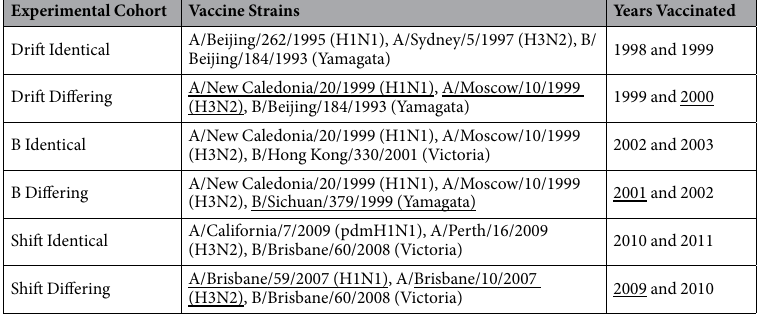
Table 1. Experimental Cohorts, Virus Vaccine Strains and Years Vaccinated. The identical groups were vaccinated in both of the years indicated with the same vaccine formulation. The differing groups were vaccinated once with the same formulation as the accompanying Identical group and once with a different formulation. The differing vaccine strains and the year the different vaccine was administered are